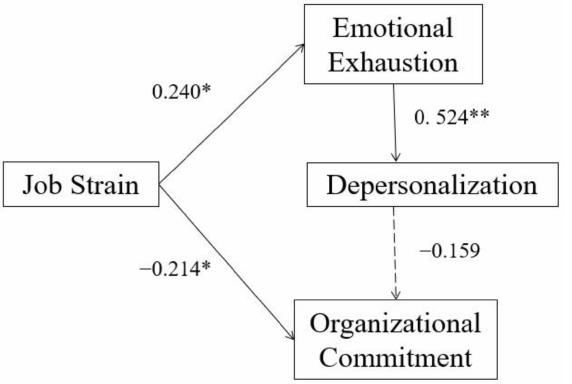
Figure 4. High social support group ( n = 99, R 2 = 0.193). * p < 0.05; ** p < 0.01 (2-tails); dotted line means unsignificant